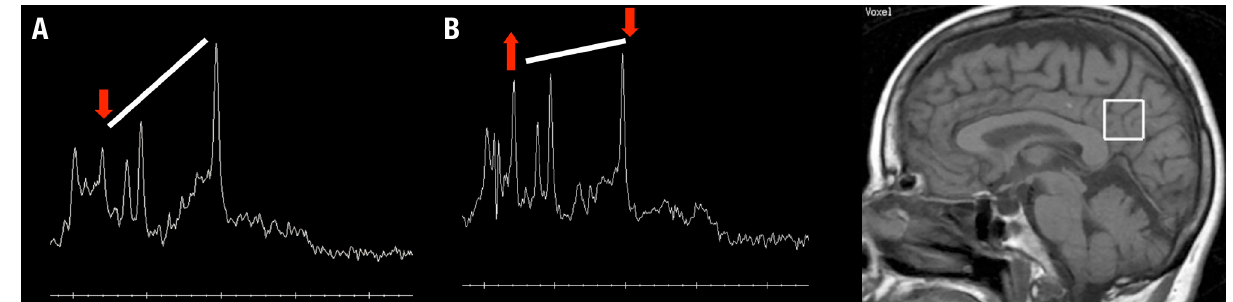
Figure 1. 1H MR spectroscopy (1H MRS) in the clinical evaluation of a patient with Alzheimer’s disease (AD). The graphic at the top is an example of 1H MRS at the posterior cingulate of a normal volunteer. Below, find an example of 1H MRS of a patient with AD. Note the reduction of N-Acetylaspartate (NAA) and increase of myoinositol (mI)